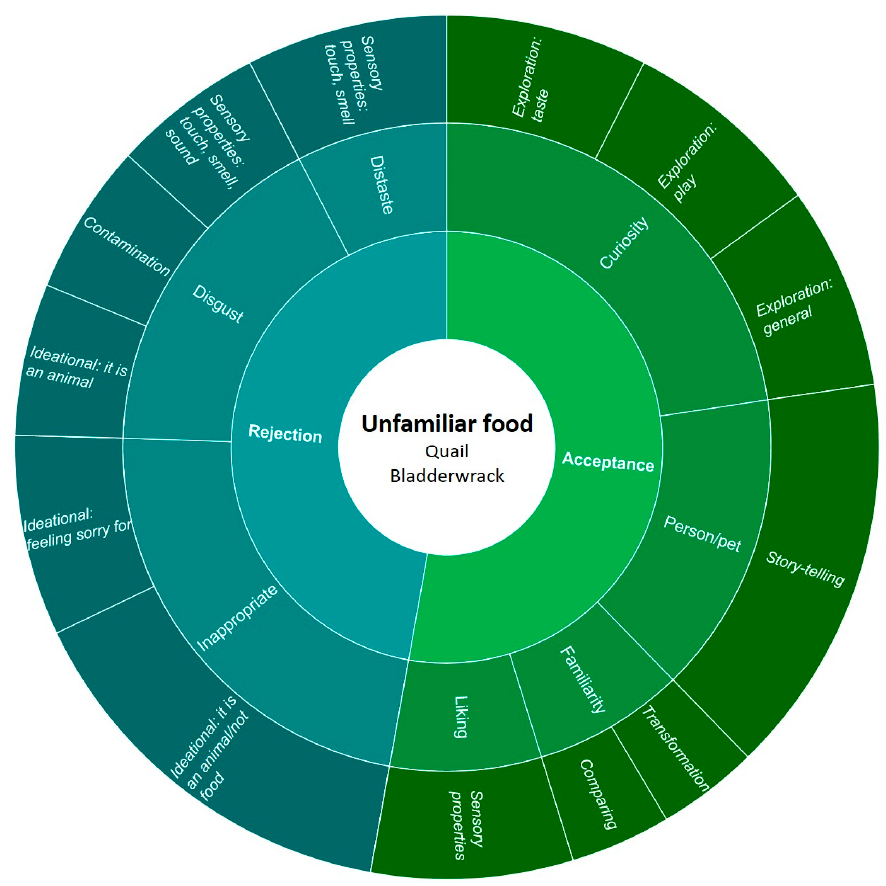
Figure 5. ATA frame overview: Metathemes, themes, and subthemes across cases.